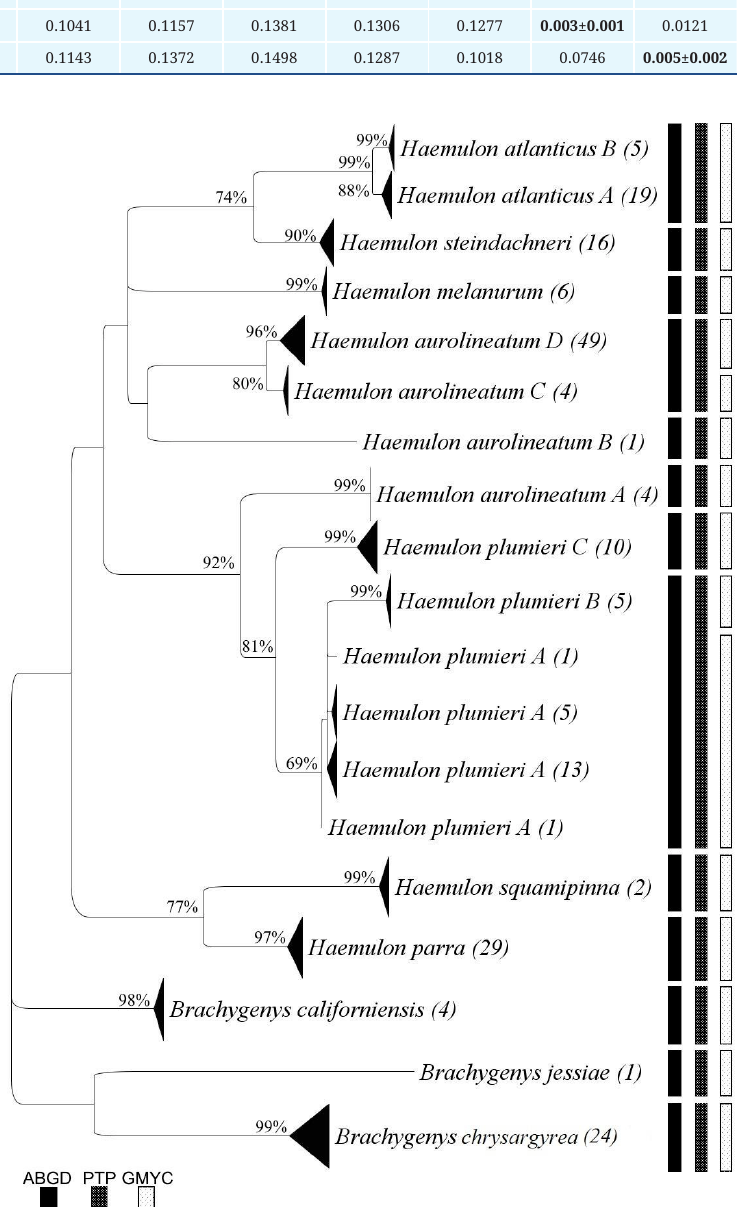
FIGURE 2 | The Maximum Likelihood tree of the Haemulon and Brachygenys specimens, based on the sequences of the mitochondrial cytochrome c oxidase subunit I gene under the TRN+G model. The numbers at each branch indicate the bootstrap values (1000 pseudoreplicates) and those between parentheses are the number of specimens analyzed. The species delimitation methods were ABGD, PTP, and GMYC (see Material and Methods